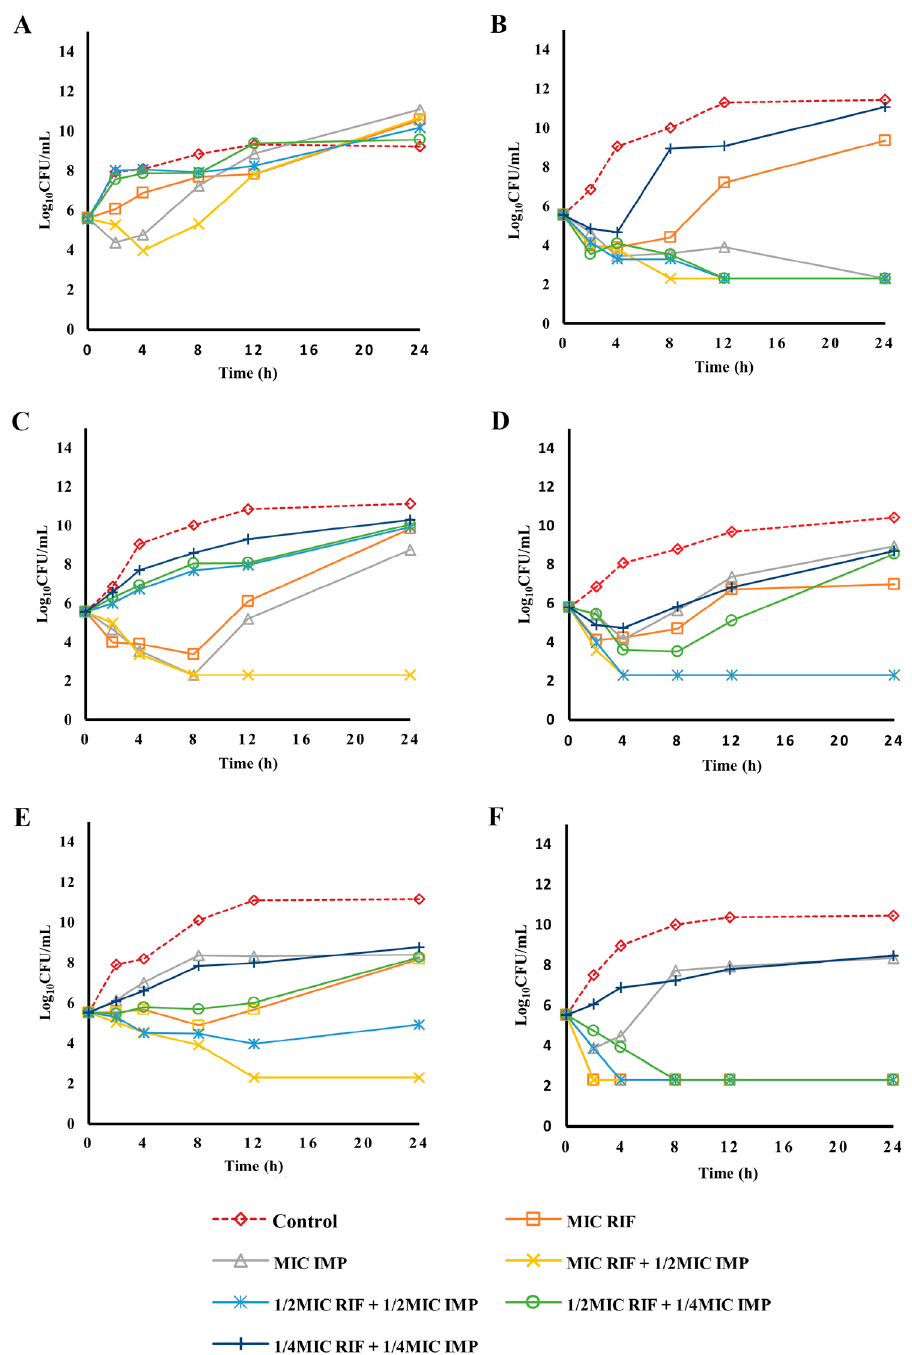
Figure 3. Time-kill kinetics of rifampicin and combination with imipenem against rifampicin-resistant and carbapenem-resistant clinical isolates of A. baumannii . SK015 ( A ), TR069 ( B ), and ST004 ( C ) are isolates with high rifampicin MIC ( ≥ 16 µg/mL), while TR131 ( D ), TR123 ( E ), and TR057 ( F ) are isolates with lower rifampicin MIC ( ≤ 8 µg/mL). Experiments were performed in duplicate. MIC, minimum inhibitory concentration; RIF, rifampicin; IMP, imipenem.